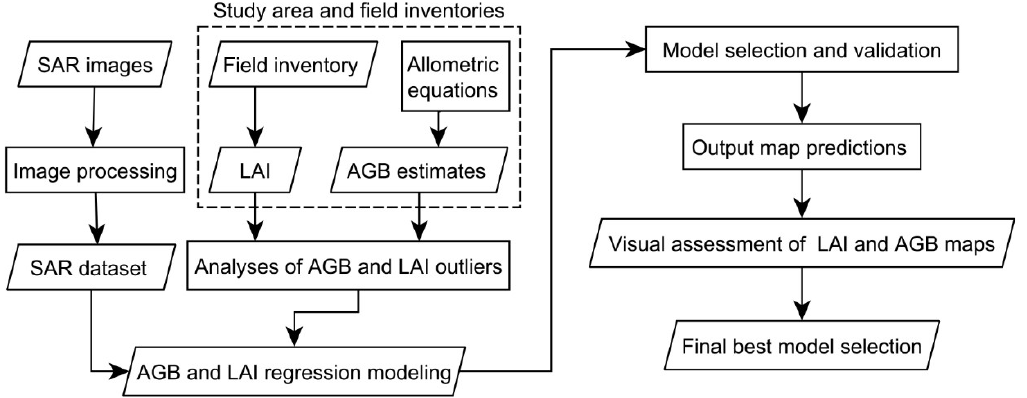
Figure 2. Flowchart for estimating above-ground biomass and leaf area index from the SAR dataset on Amazon floodplain forests.